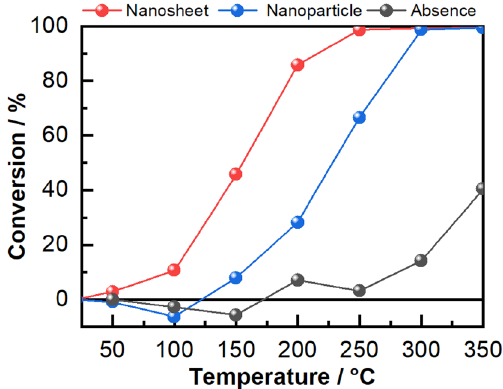
Figure 1. Allyl mercaptan conversion percentage (powder: 0.01 g, flow: 100 cm 3 /min, gas concentration: 20 ppm, tube diameter: 10 mm).